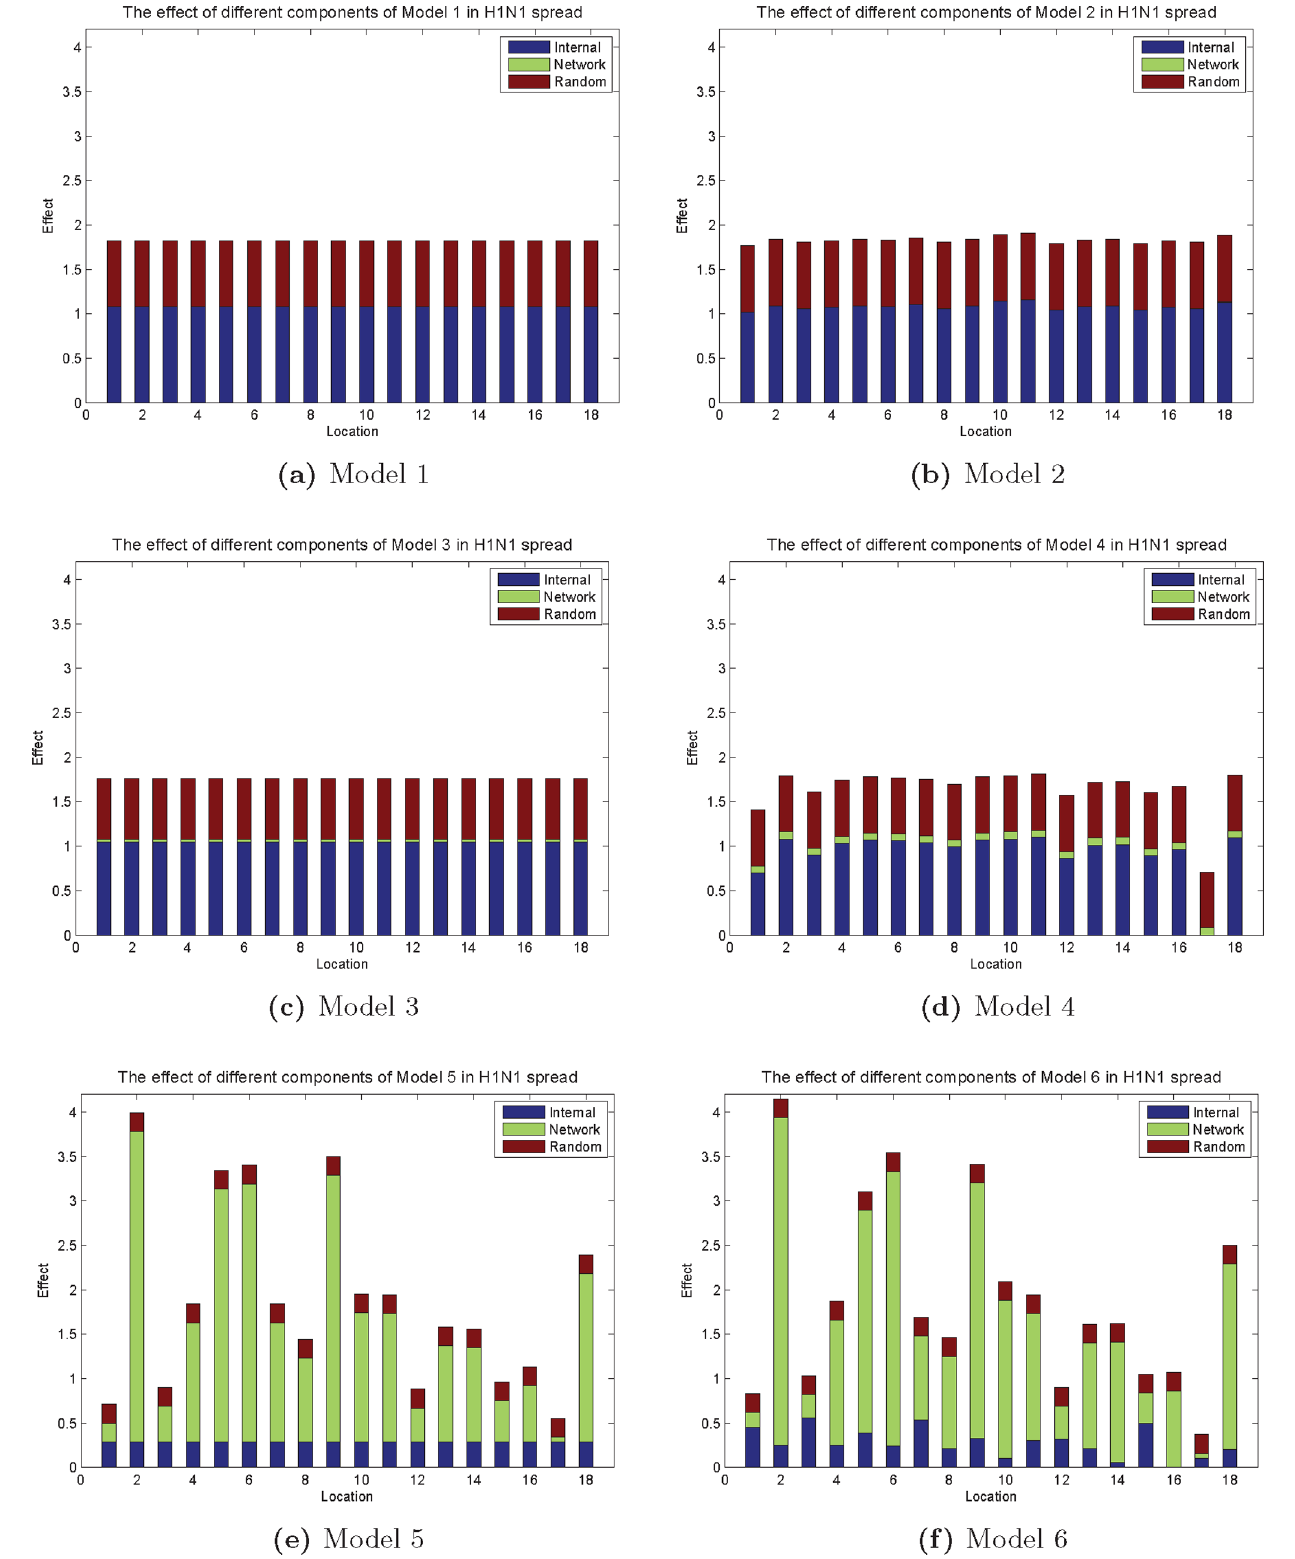
Figure 5. The comparison of different effects in 2009 H1N1 spread in Hong Kong. The internal effect is the exponential value of y or y l . The network effect is the exponential value of w or w l . The random effect is the exponential value of e .